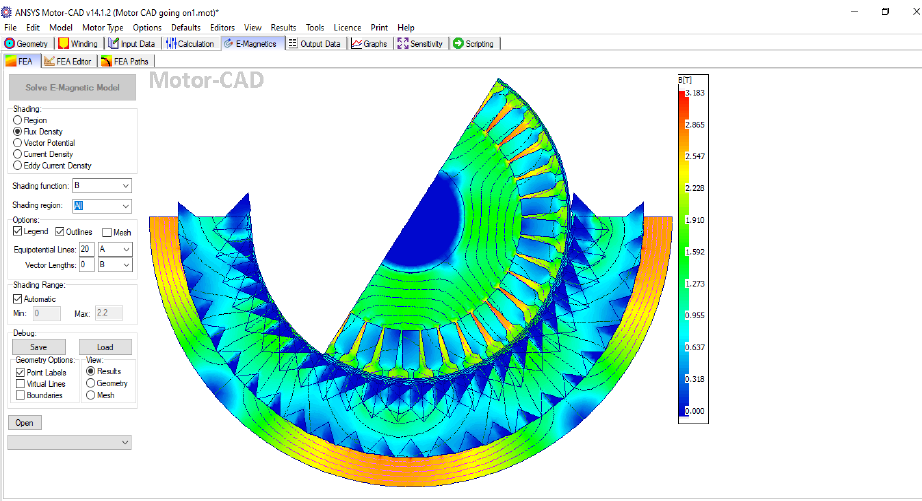
Figure 8. Plot of Flux Density.